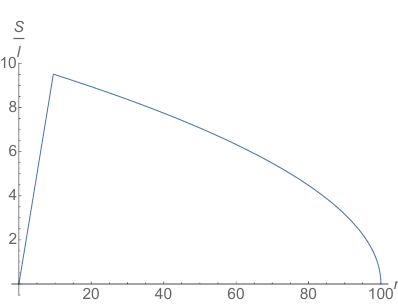
Figure 3 . The Page curve for our unitary model, computed using the area of the HRT surface (we’ve taken L 0 =‘ = 10 and 4 G = 1, and plotted S R ‘